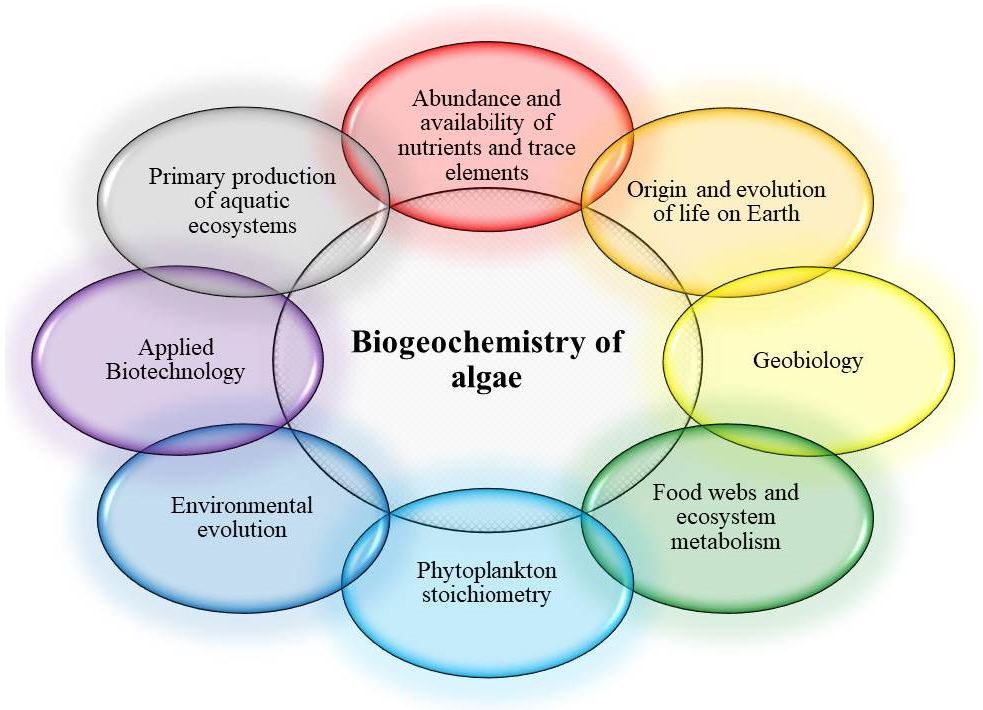
Figure 1. Main applications of bioinorganic chemistry of algae.